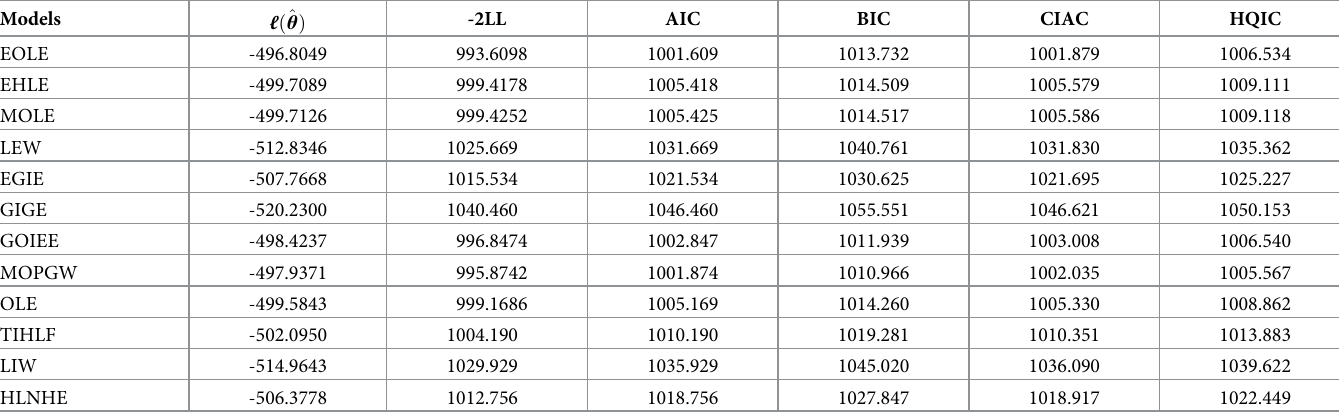
Table 7. Calculated value of -2LL, AIC, BIC, CIAC, and HQIC of different models.